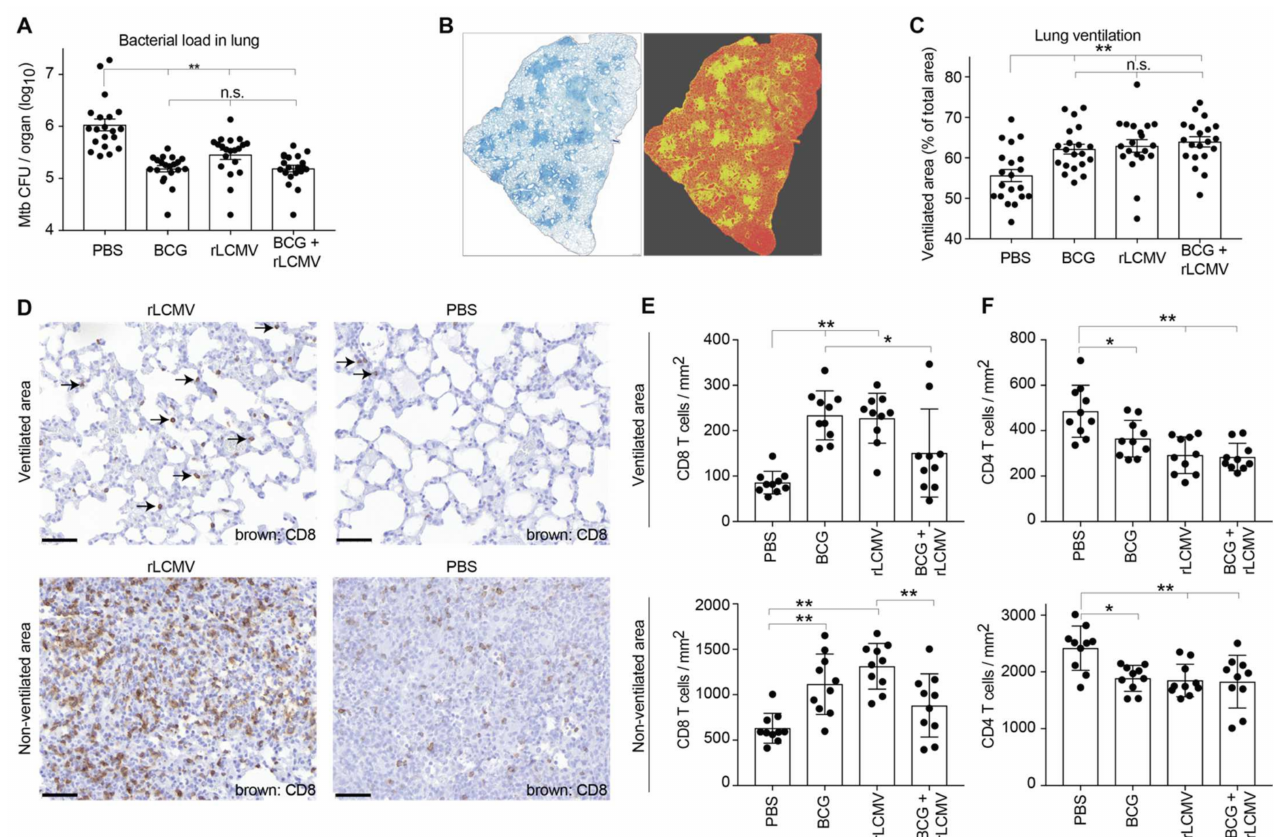
Figure 6. rLCMV immunization reduces Mtb loads in lung, improves lung pathology, and augments CD8 T cell recruitment to the lung. Mice were immunized with BCG s.c. and/or with rLCMV i.m. and challenged with Mtb as outlined in Figure 5A, and lungs were analyzed at week 4 after challenge. ( A ): Bacterial loads in lung. ( B ): Exemplary microscopy image of a whole-lung cross section stained by hematoxylin/eosin (left). Ventilated and non-ventilated regions were determined by computer-assisted image analysis and are color-coded for illustration purposes in red and yellow, respectively (right). ( C ): The percentage of ventilated surface on whole-lung cross sections, computer- assessed as in ( B ), was calculated as “(ventilated surface):(ventilated + non-ventilated surface)”. ( D – F ): Lung sections were processed for immunohistochemical detection of infiltrating CD8 and CD4 T cells. D : Representative images from ventilated (top) and non-ventilated (bottom) lung areas of rLCMV-only vaccinated animals and PBS controls. Arrows point out infiltrating CD8 T cells in the alveolar walls of ventilated lung. Magnification bars: 50 µ m. ( E , F ): Infiltration densities of CD8 ( E ) and CD4 T cells ( F ) in ventilated (top) and non-ventilated (bottom) areas of the lung were determined by computer-assisted image analysis. Symbols in ( A , C ) show individual animals from two independently conducted experiments, which each consisted of two groups of five mice that were immunized and challenged independently. Symbols in ( E , F ) show results from one of these experiments with two groups of five mice immunized and challenged independently. Bars show the mean+/ − SEM. Data were analyzed by one-way ANOVA followed by Bonferroni’s post-test. * p < 0.05, ** p < 0.01, n.s.: not statistically significant, p ≥ 0.05. In ( E , F ) only statistically